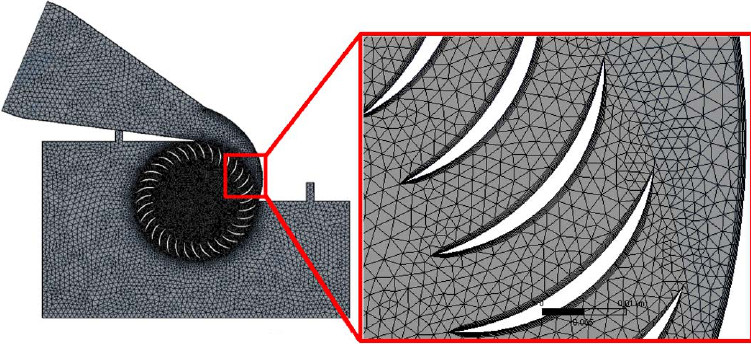
Figure 5. 2D-computational mesh with a zoom view close to the inlet of the